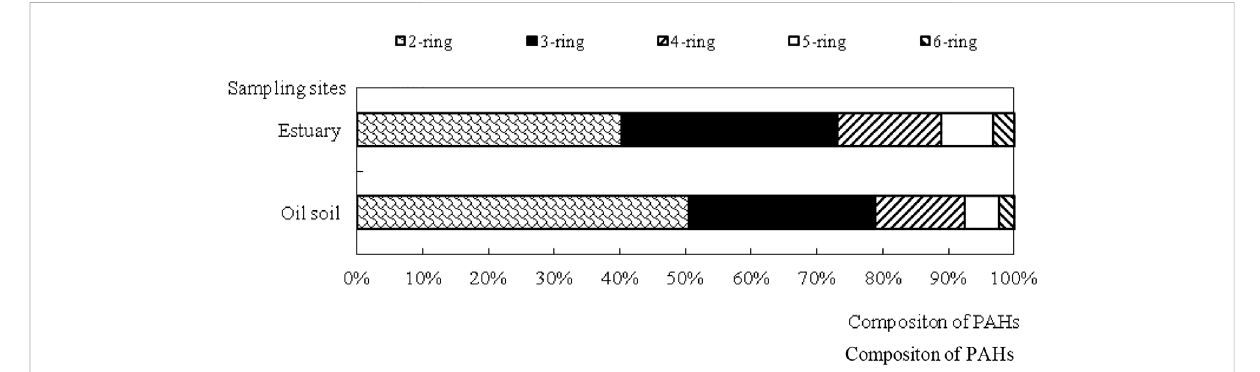
FIGURE 2 Compositions of different benzenes in total PAHs in Oil soil and Estuary soil samples.